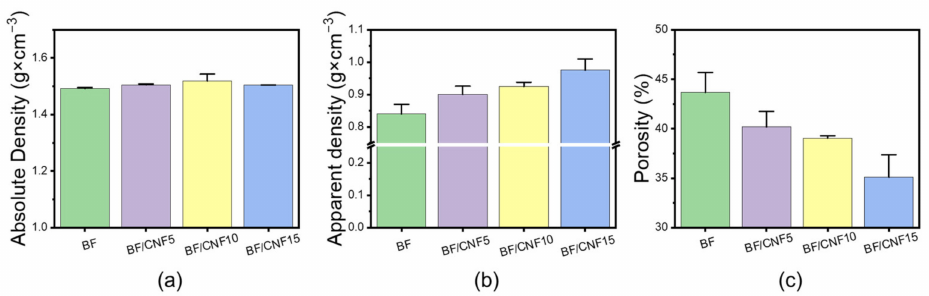
Figure 5. Effect of CNF addition level on the physical properties of BF/CNF fibrous preforms. ( a ) Absolute density, ( b ) apparent density, and ( c ) calculated porosity.